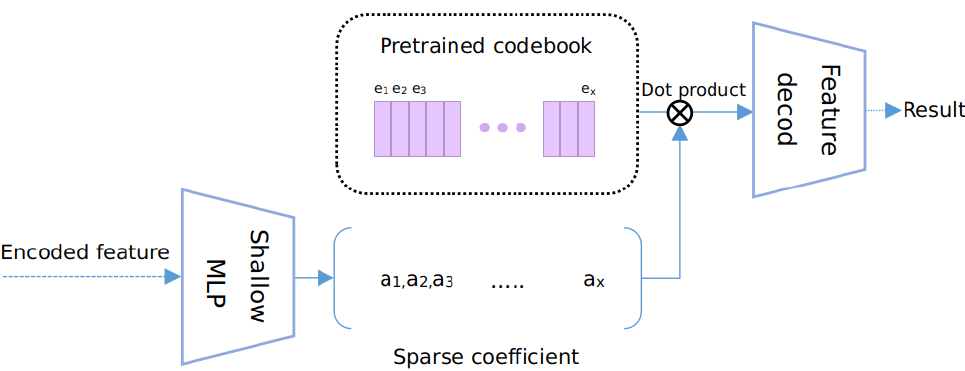
Figure 3. The pipeline of the learning sparse representation coefficient